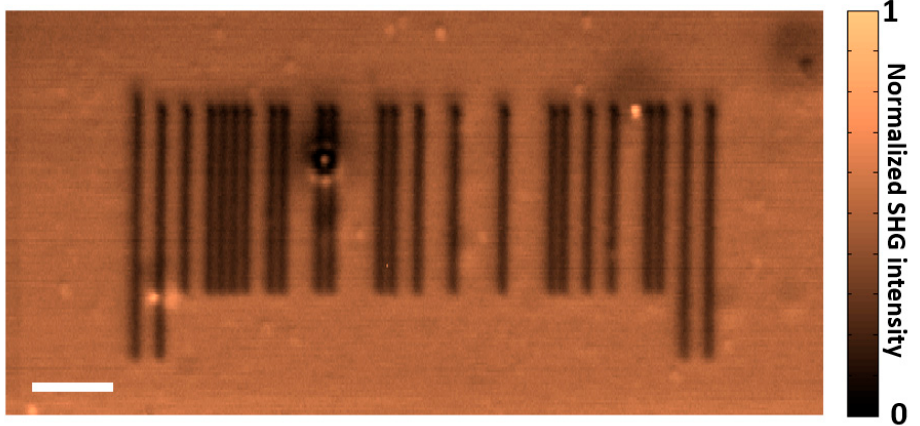
Figure 2. Normalized SHG image of a barcode (scale bar: 10 μ m).